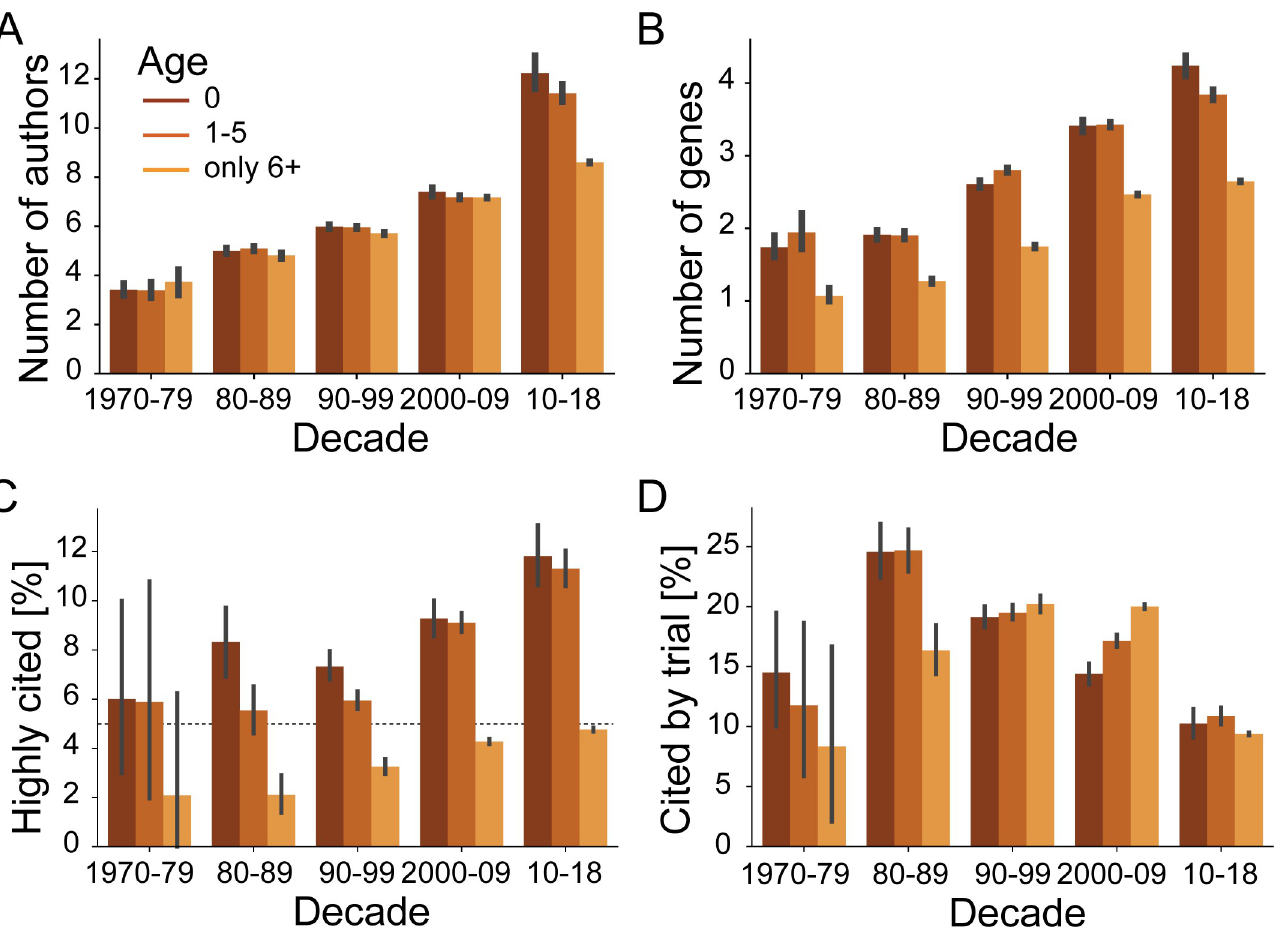
Fig 2. Publications introducing newly highlighted genes are published by larger teams, highlight more genes in title and abstract, and are more likely to become highly cited. (A) Average number of authors for publications highlighting at least 1 gene aggregated by age of highlighted gene and by decade. (B) Average number of highlighted genes per publication for publications highlighting at least 1 gene aggregated by age of highlighted gene and by decade. (C) Share of highly cited publications (among top 5% of year of publication) per decade. Dashed line shows 5% baseline. (D) Share of publications highlighting at least 1 gene aggregated by age of highlighted gene and by decade that are cited by at least 1 clinical trial. Error bars show 95% confidence intervals inferred by bootstrap. Gene ages at publication are grouped identically in all panels and as shown in legend of panel A. Combines data from MEDLINE, NCBI gene and taxonomy information, gene2pubmed, PubTator, and iCite. For data underlying the figure, see https://doi.org/10.21985/n2-b5bm-3b17.